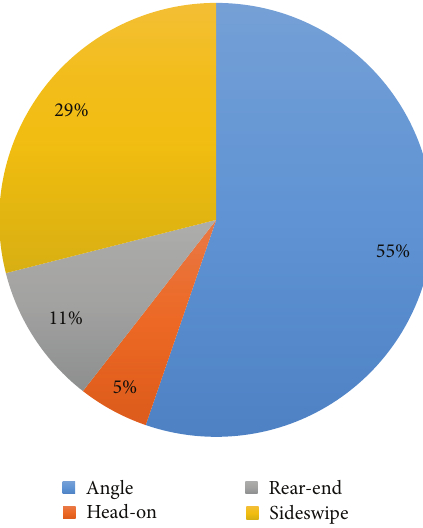
Figure 9: Crash type of e-bike fatal crashes.